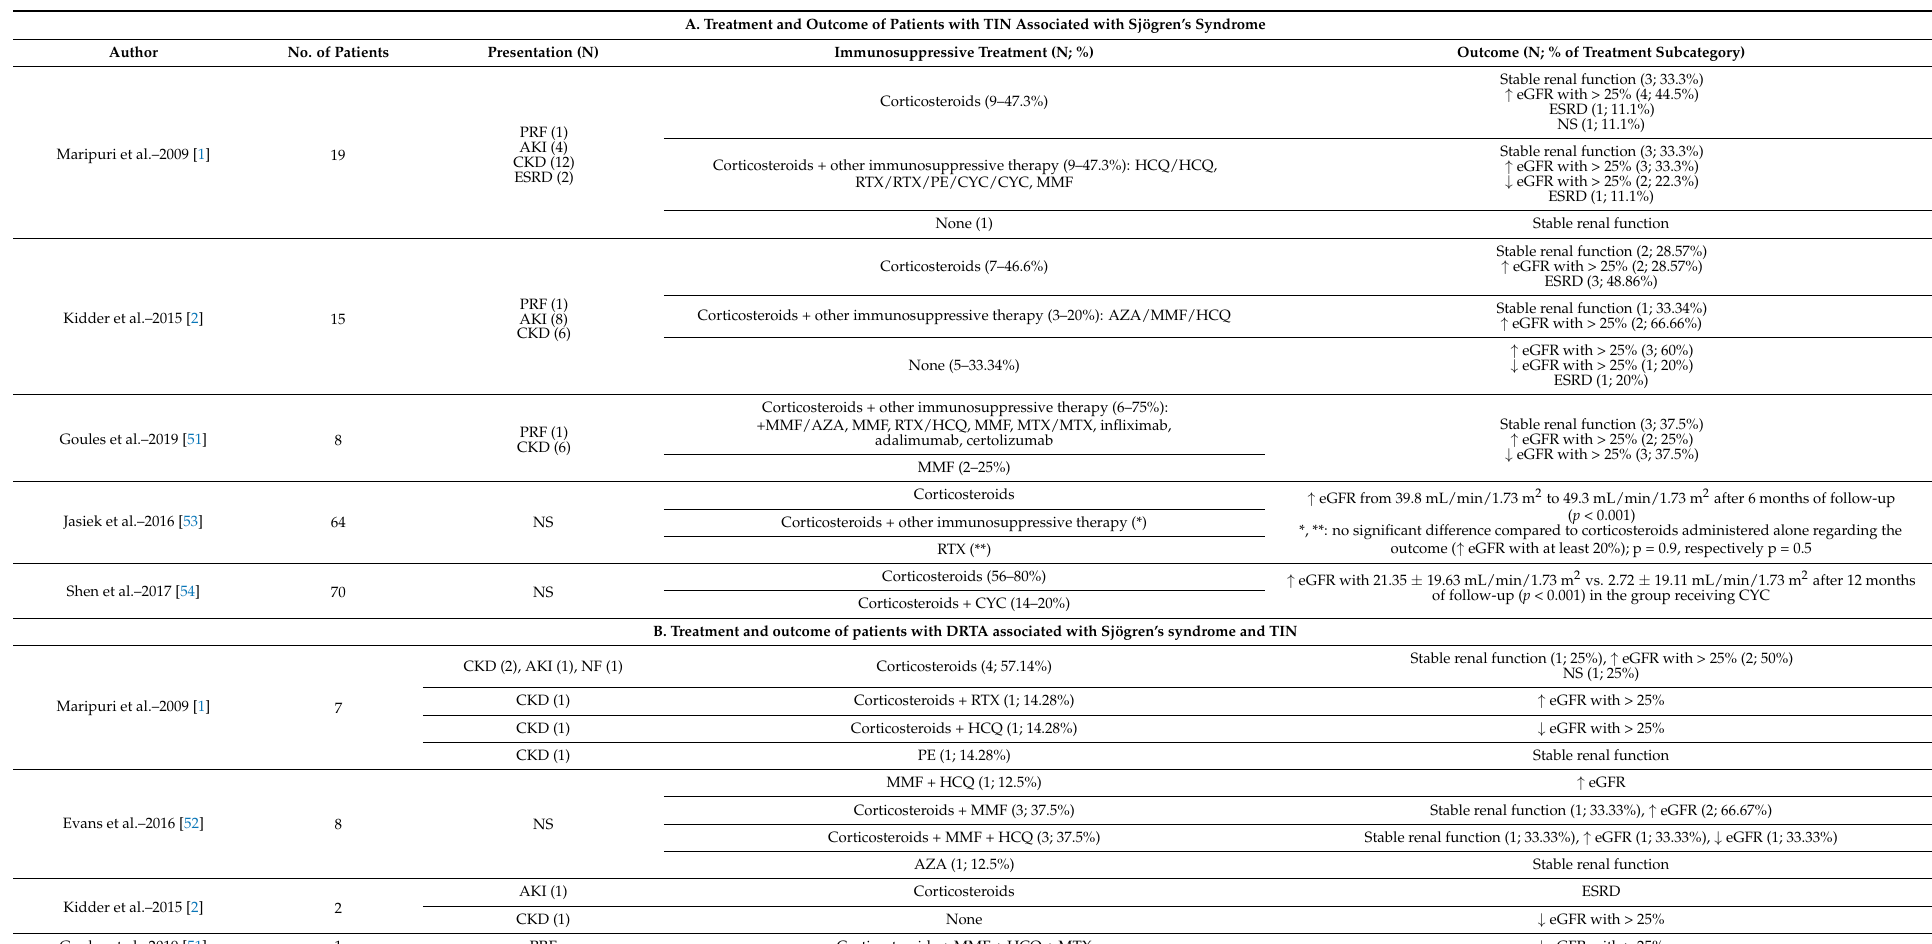
Table 2. Treatment and outcome of patients with Sjögren’s syndrome, that is associated with TIN ± dRTA.